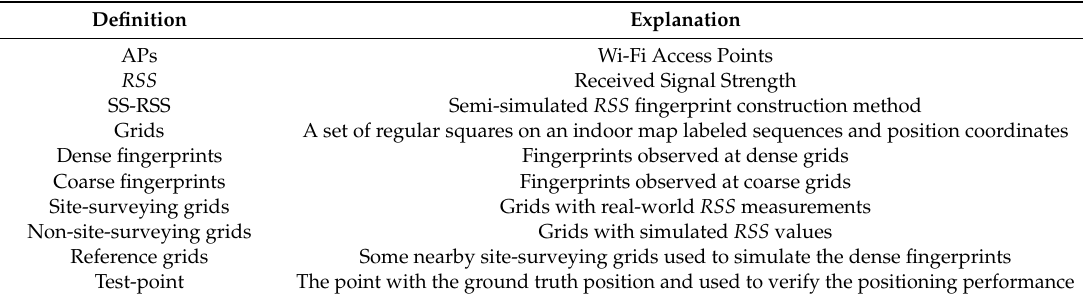
Table 1. List of abbreviations and definitions.